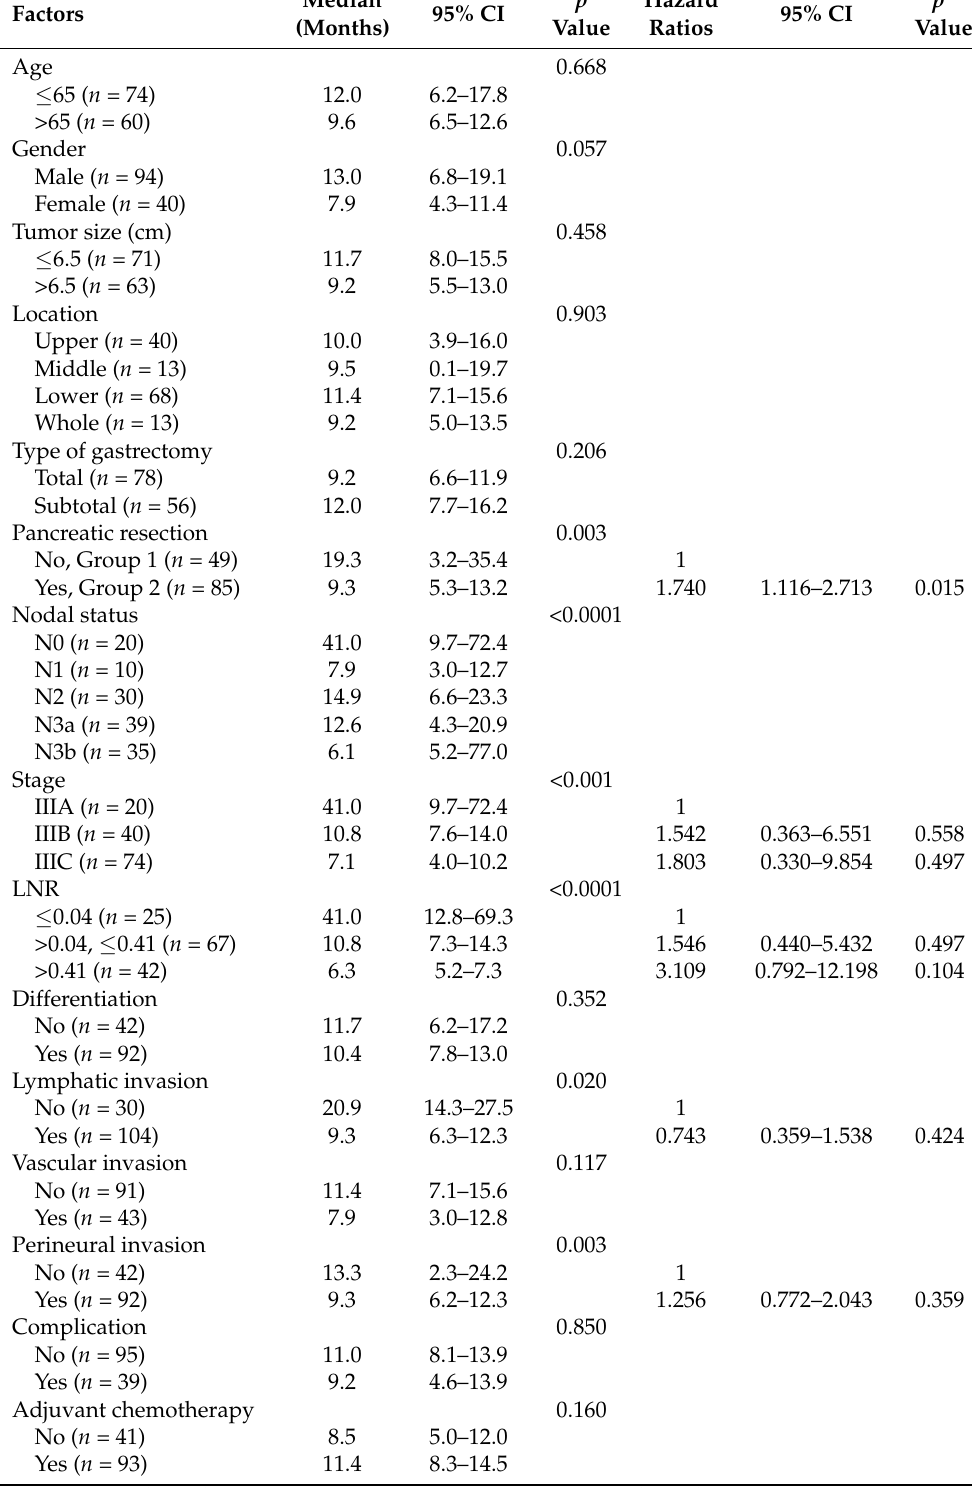
Table 2. Univariate and multivariate analysis of prognostic factors for disease-free survival in group 1 and 2